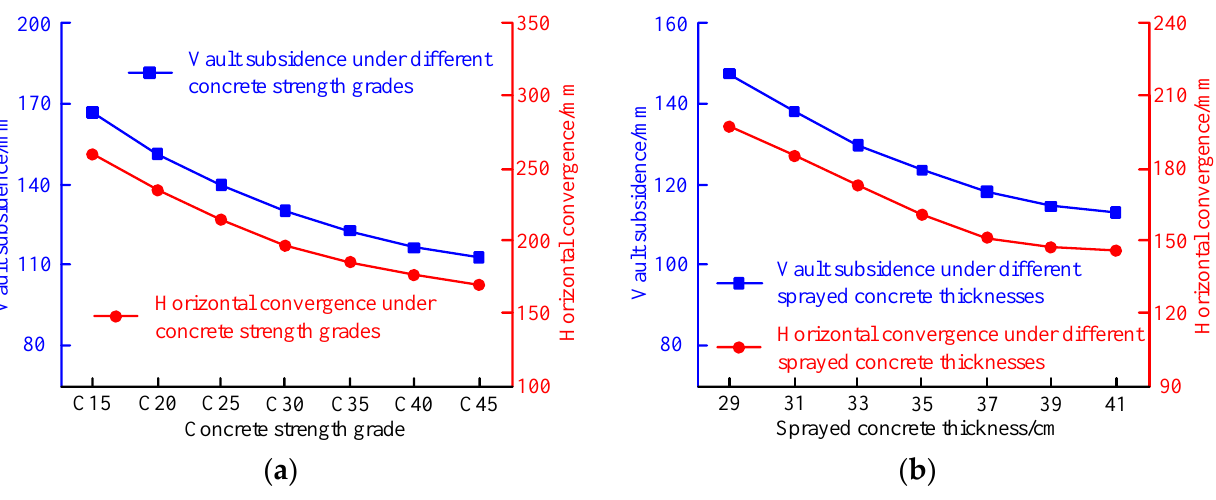
Figure 9. ( a ) Tunnel deformation curves under different concrete strength grades and ( b ) tunnel deformation curves under different sprayed concrete thicknesses. Tunnel deformation curves under different lining parameters.